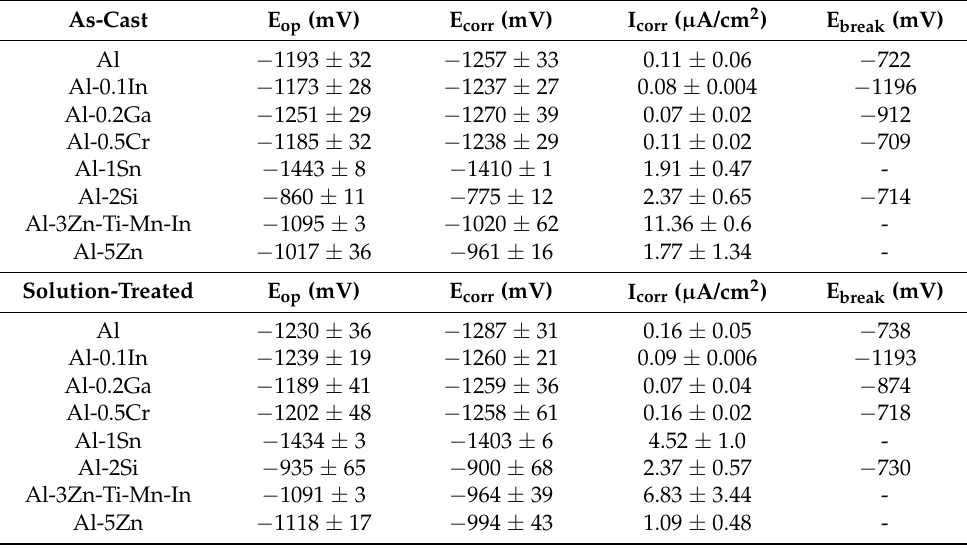
Table 4. Corrosion properties of the Al-based alloys in as-cast and solution-treated